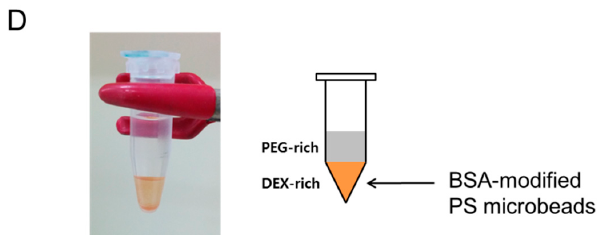
Figure 5. Side-view pictures and results of the partitioning of microparticles with different surfaces. ( A ) unreacted, tosyl-activated Dynabead ® ; ( B ) microparticles modified with amino-dextran (MW 10,000); ( C ) microparticles modified with methoxy-(polyethylene)glycol-amine (MW 10,000) and ( D ) microparticles modified with bovine serum albumin (MW ~66,500). The composition of the ATPS was 10% (w/w) PEG–5% (w/w) DEX. Other conditions are described in the Experimental section.